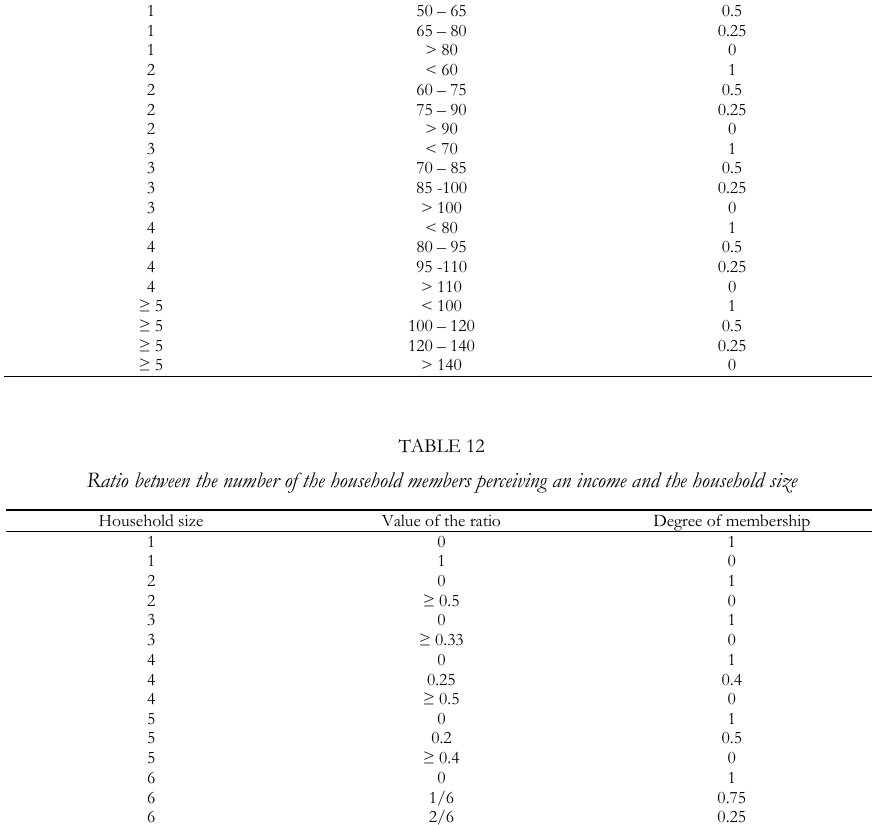
Household size and dimension (in square meters) of the residence Square meters